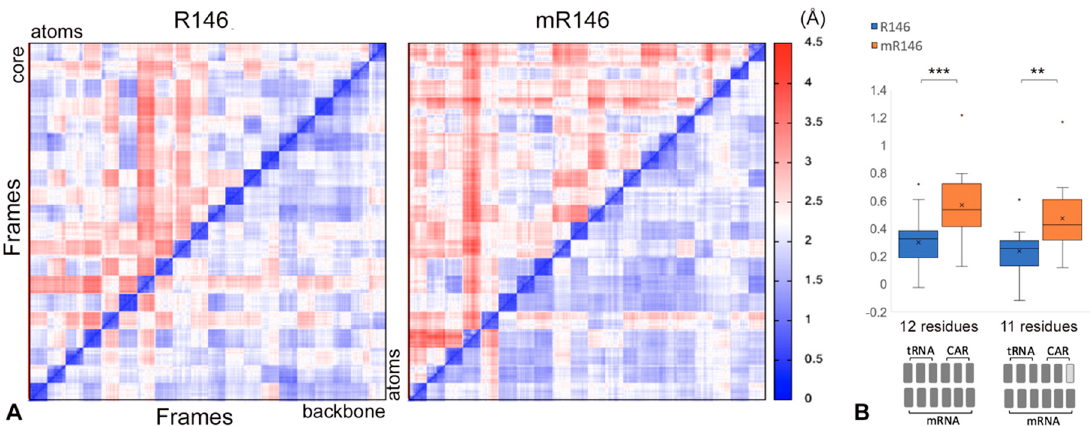
Figure 5. Comparisons across trajectory experiments. ( A ) 20 independently-initiated trajectories were subjected to pairwise RMSD comparisons (between all pairs of frames) using backbone heavy atoms (bottom right-hand triangles below the diagonals) or “core” base and guanidinium group heavy atoms (top left-hand triangles) for 12 residues: CAR (C1054, A1196, (m)R146), +1 codon (+1 G1, +1 C2, +1 U3), A site (A-C1, A-C2, A-U3) and tRNA anticodon (nt36, nt35, nt34). The methylated R146 subsystem had a greater difference between RMSD of backbone and core atoms (right) compared to unmethylated R146 (left). Each trajectory was sampled with 41 frames (1 frame per ns). ( B ) For each of the 20 trajectories, the average RMSD difference with the other 19 trajectories was calculated. The differences (in Å) between the core and backbone atom RMSD means (averaged by experiment) were graphed. Bootstrap analysis indicated that mR146 trajectories had a significantly greater difference than for R146 (12 residue; p < 0.001 ***; 10,000 bootstrap samples). This was also true when the R146 residue was excluded from the RMS2D calculations (11 residue; p < 0.01 **).